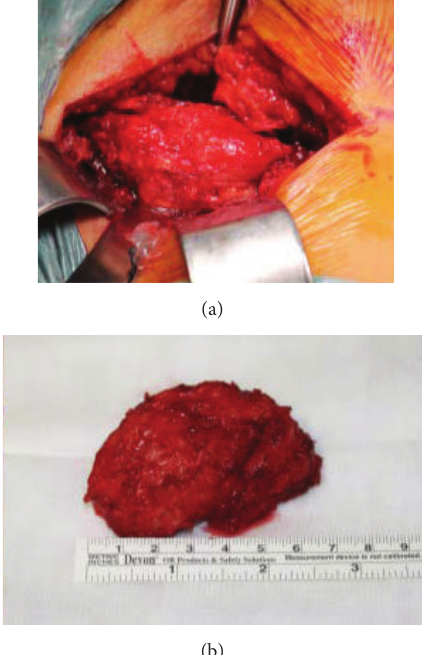
Figure 2: (a) Intraoperative picture showing a lumbar spine midline approach, exposing the tumor in situ in contiguous to the spinous processofL5causingadjacentleftparaspinalmuscularcompression. (b) Intraoperative picture of the resected tumor with an approxi- mately 7 cm axis-length.